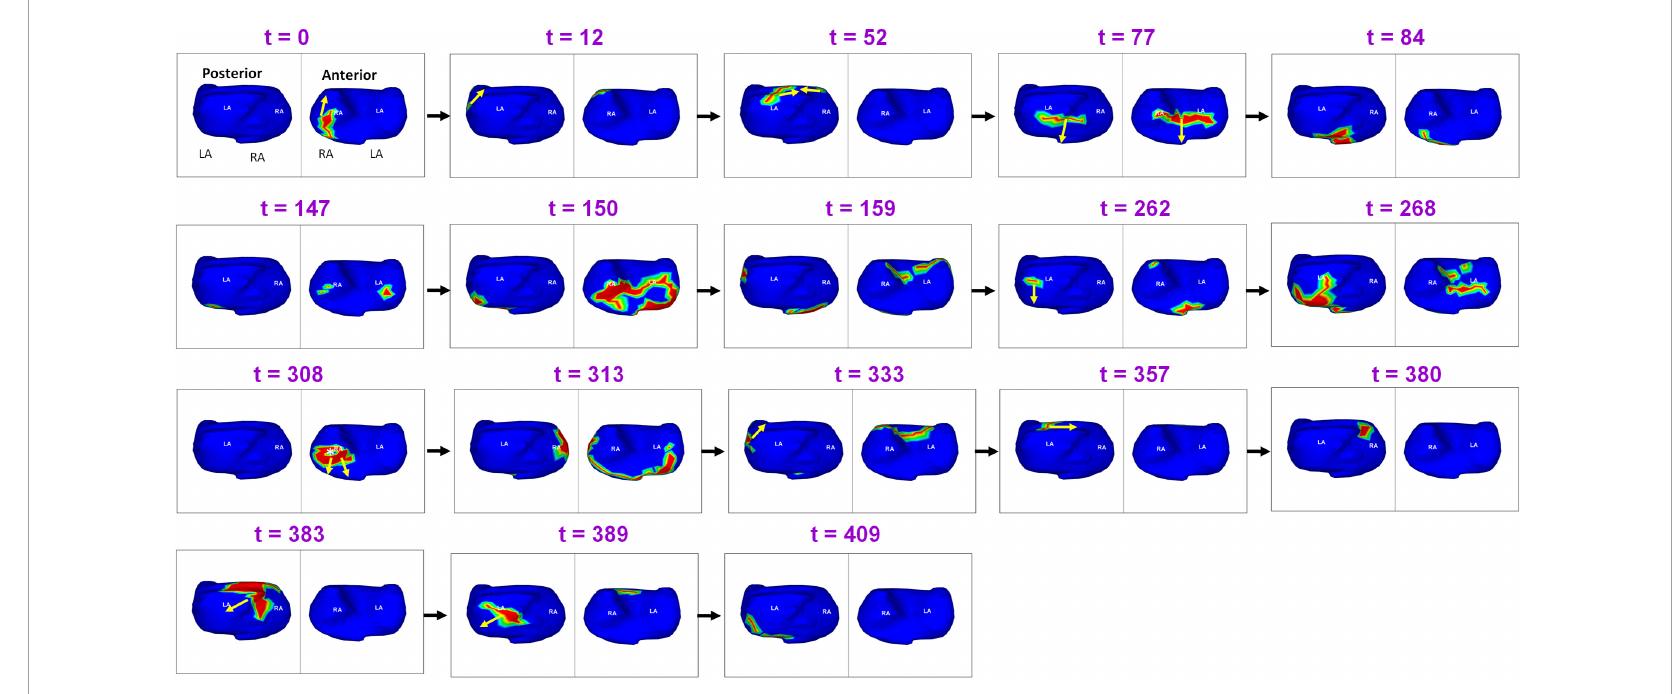
FIGURE8 Recurrent AF maps of a patient, obtained 6 months after ablation. The maps show the presence of pulmonary and non-pulmonary sources and the resulting wavefront dynamics ( Supplementary Video 5